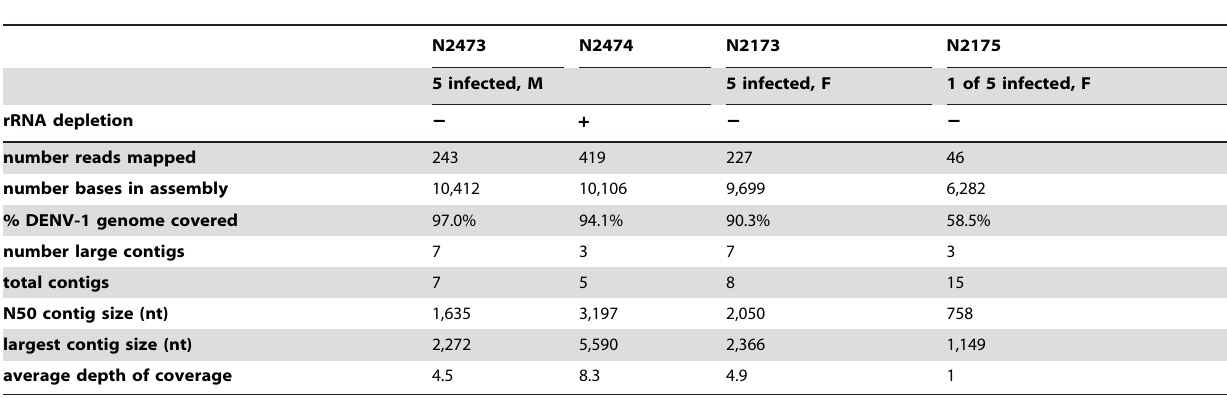
Table 2. Results of reference-guided